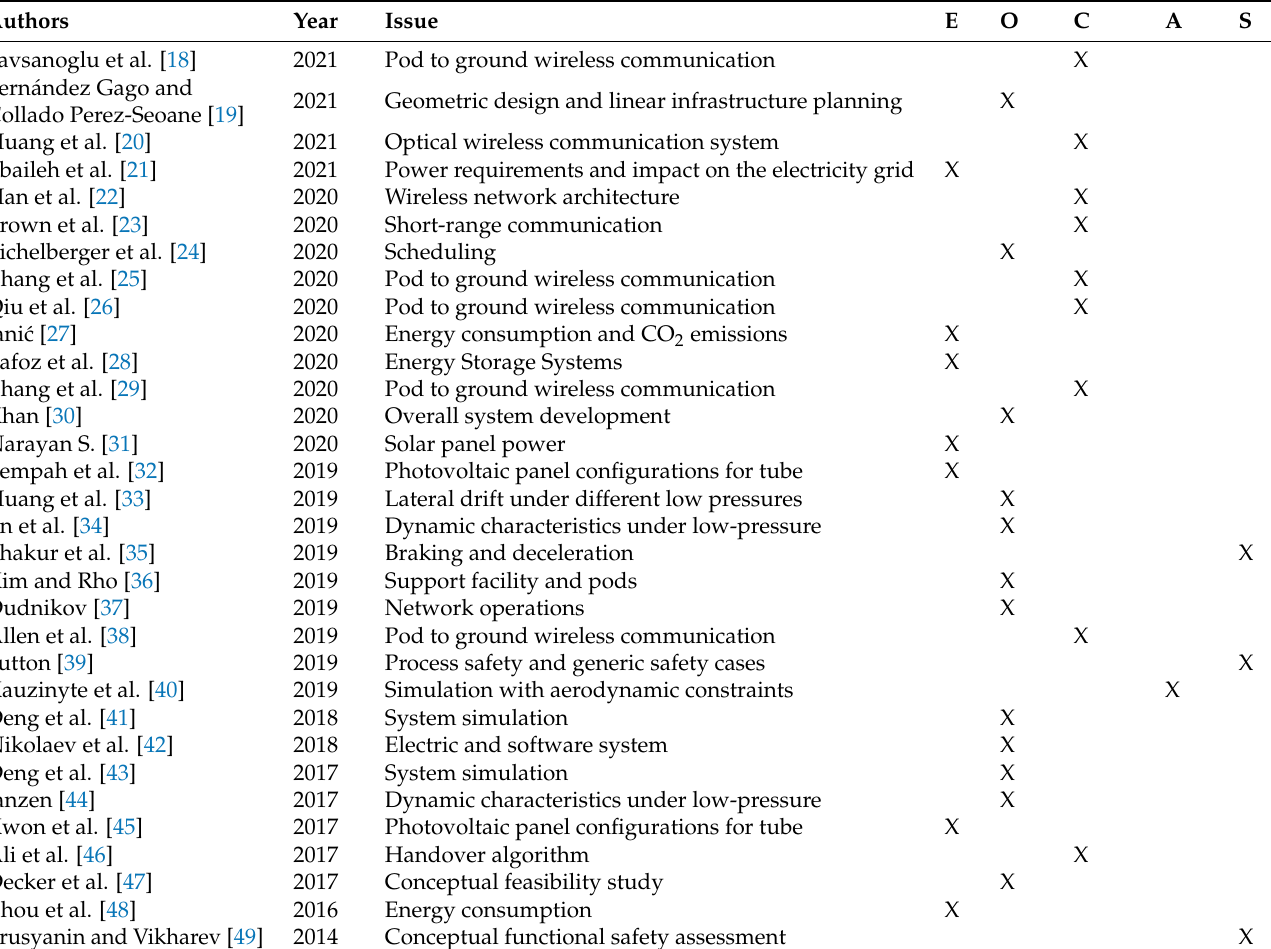
Table 1. Issues identified in research on the Hyperloop